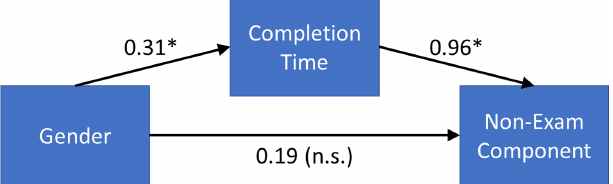
FIG. 9. Mediation model path diagrams depicting the total, direct, and indirect effects of Gender on nonexam components with the indirect effect operating through a single mediator, completion time. [* p < 0 . 001 . (n.s) = not significant.]